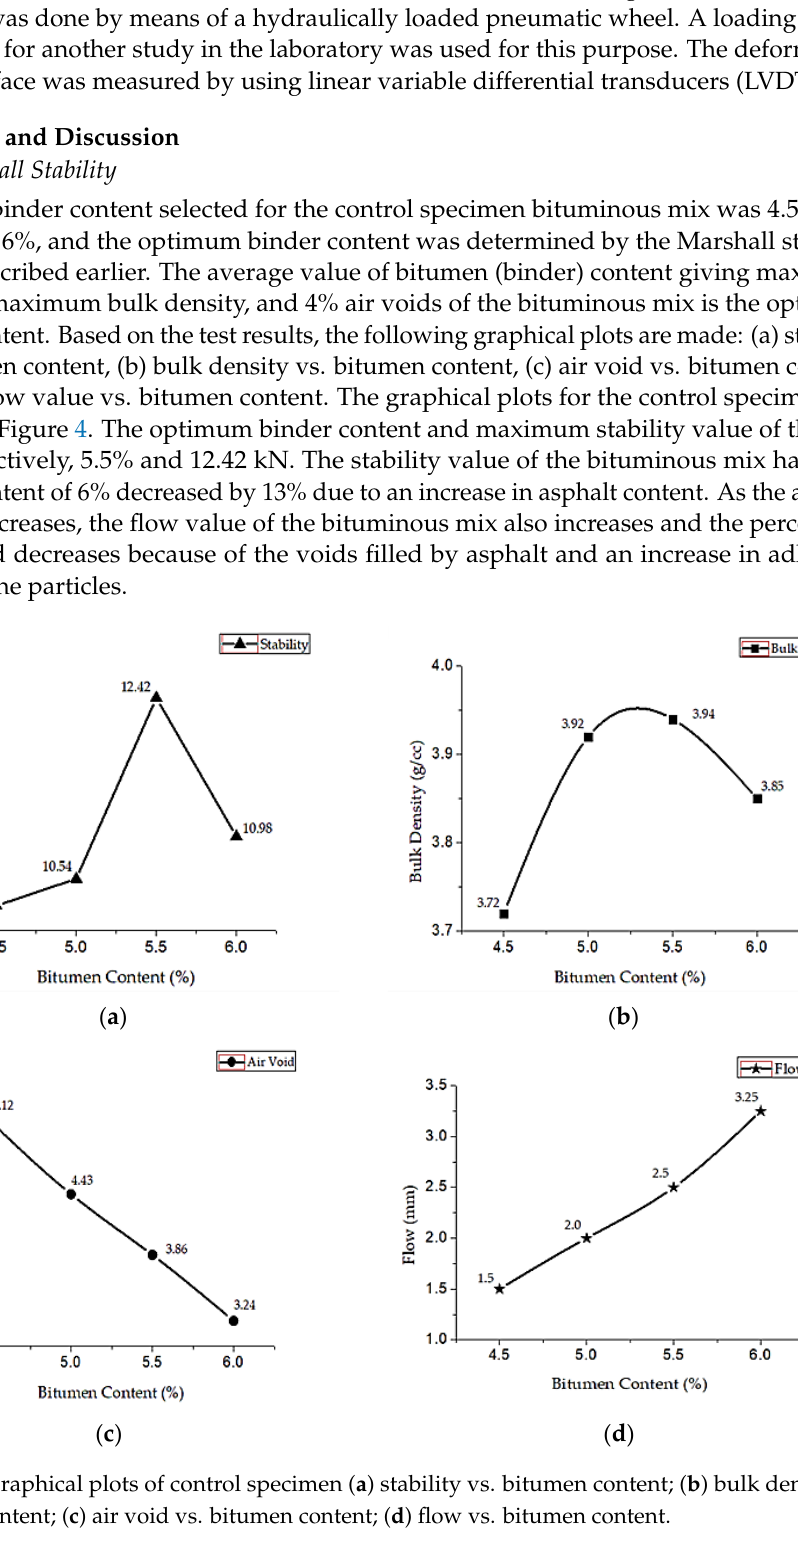
Figure 4. Graphical plots of control specimen ( a ) stability vs. bitumen content; ( b ) bulk density vs. bitumen content; ( c ) air void vs. bitumen content; ( d ) flow vs. bitumen